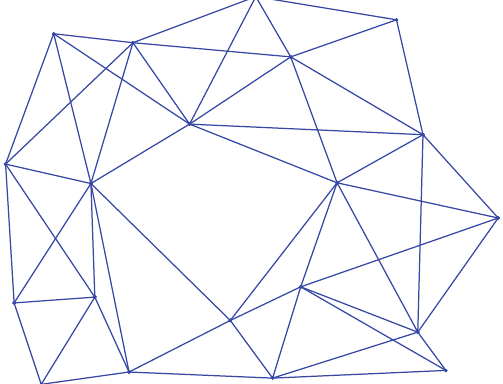
Figure 2: A sensor network with 20 nodes and 51 links.